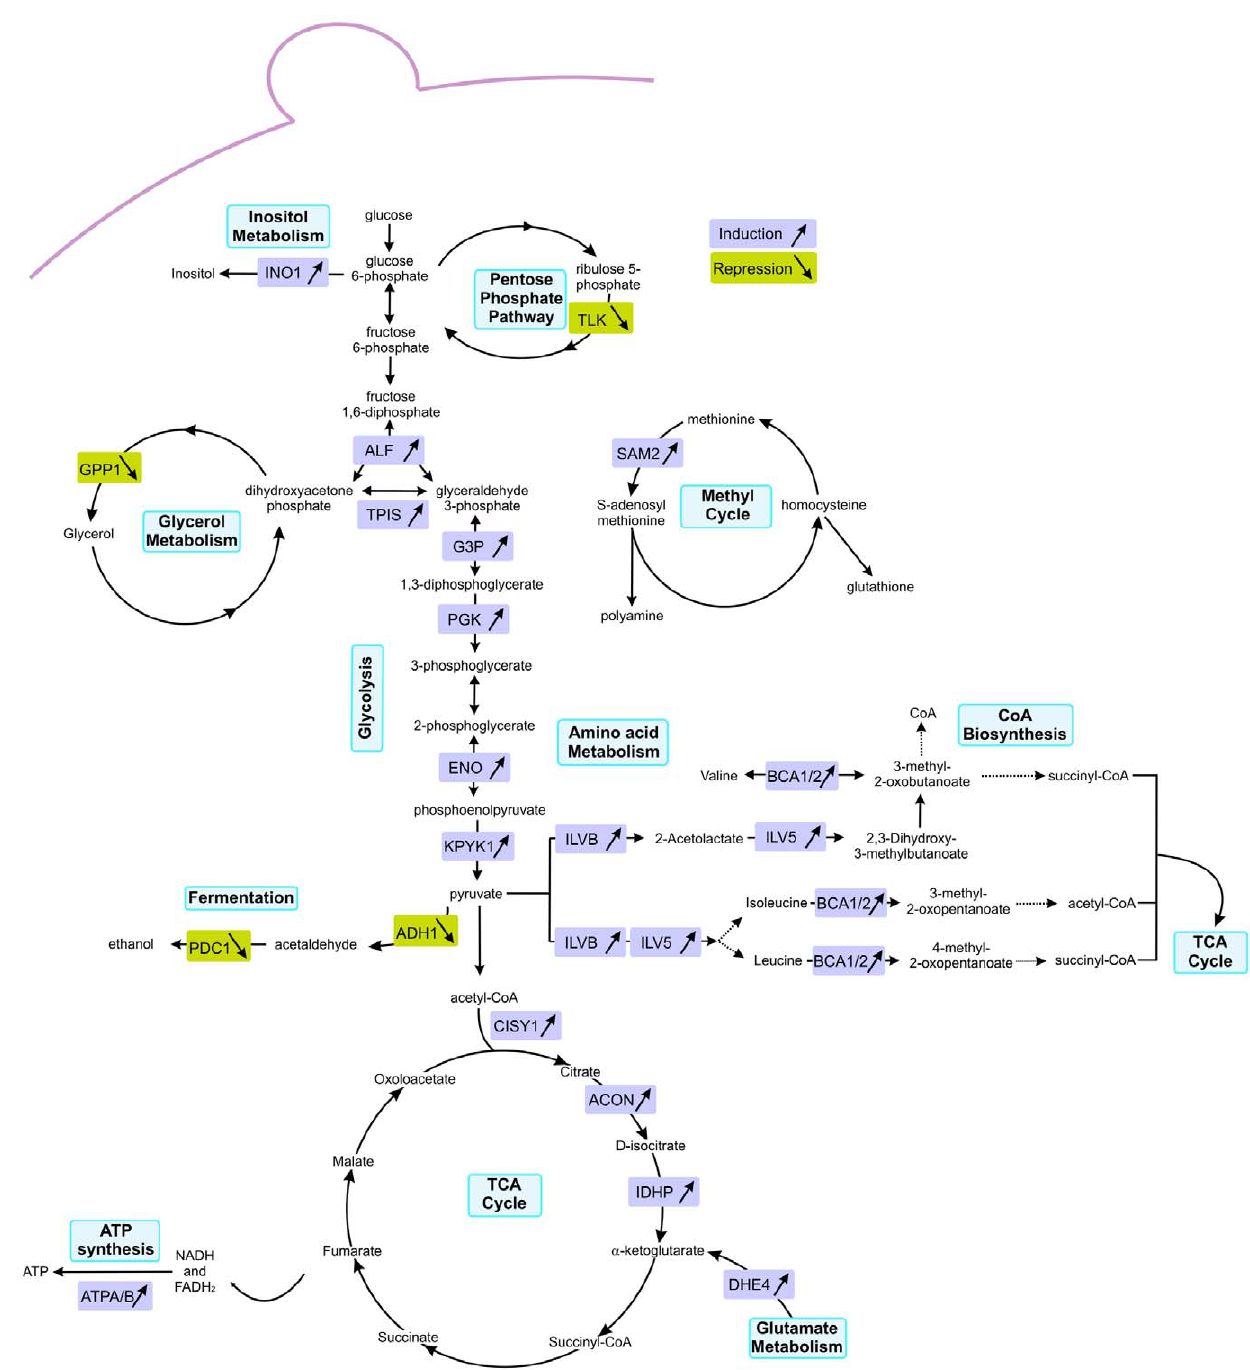
Figure 6. Major metabolic pathways altered in BTTR-L55P. Differentially expressed proteins are highlighted, those induced are framed in purple and those repressed are framed in green. Protein full names can be identified in Table 1.